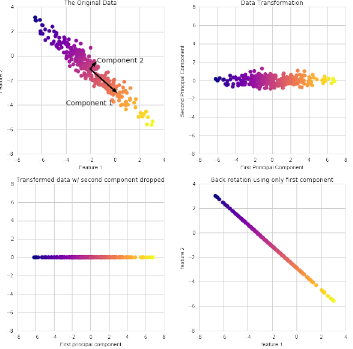
Figure 2. Principal Component Analysis